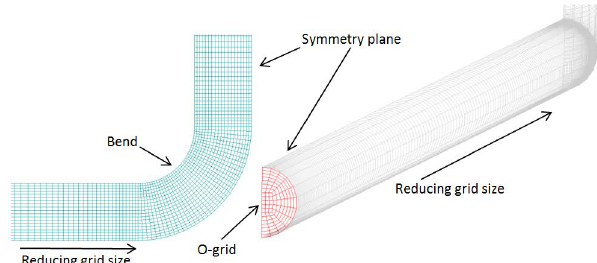
Figure 4. The computational grid for the experimental set-up. The cross section is an O-grid, even across the